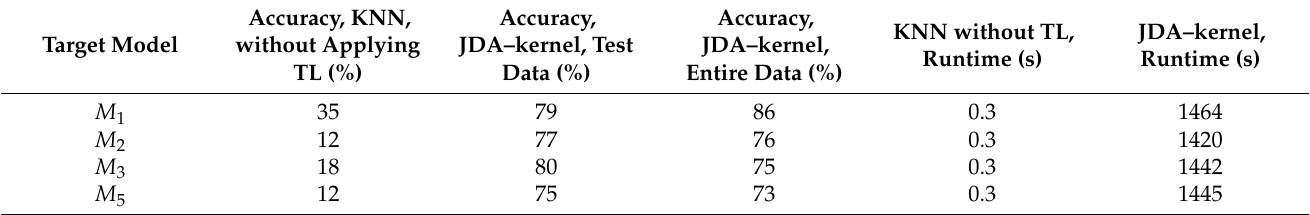
Figure 8. Confusion matrix associated with each model for unknown DLs and DIs and loading event. Table 6. Accuracy and runtime results comparison, unknown DLs, DIs, and loading.